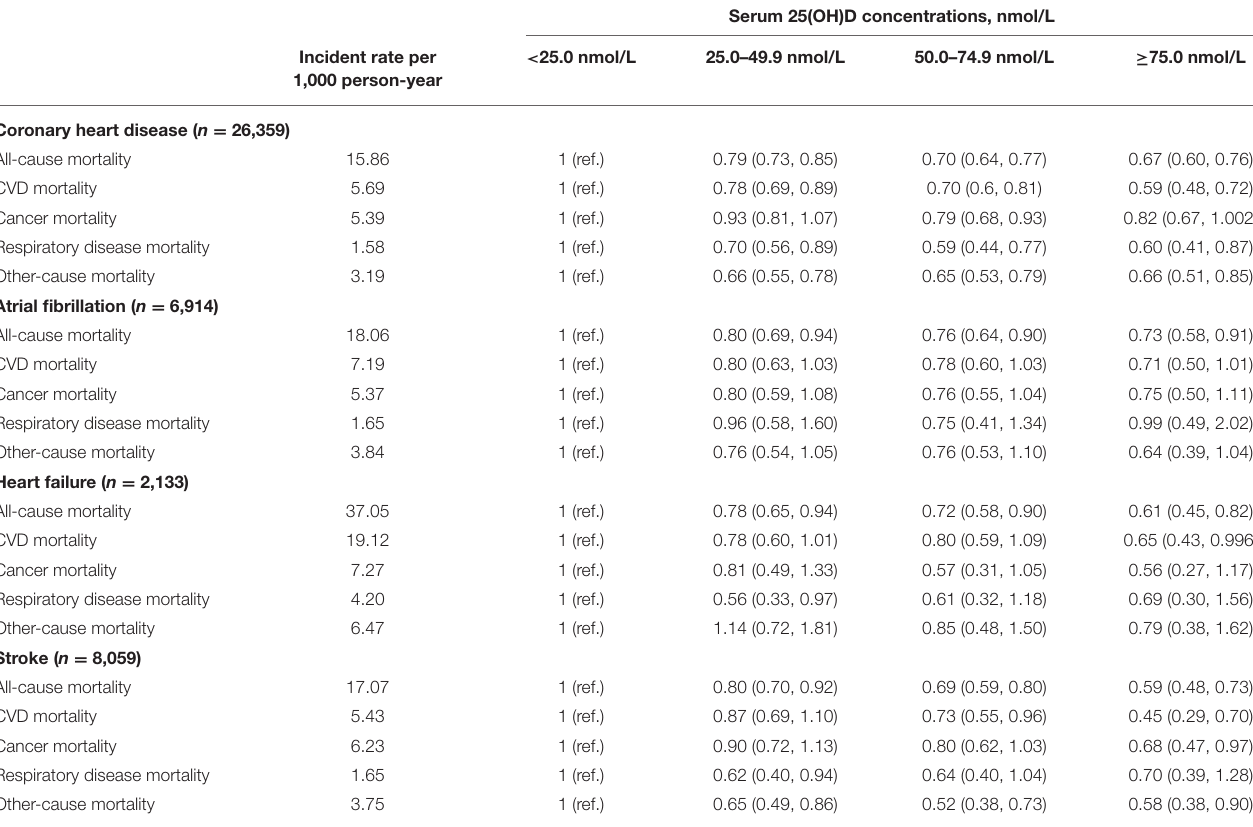
TABLE 4 | Hazard ratios for all-cause and cause-specific mortality by serum 25(OH)D among patients with CVD